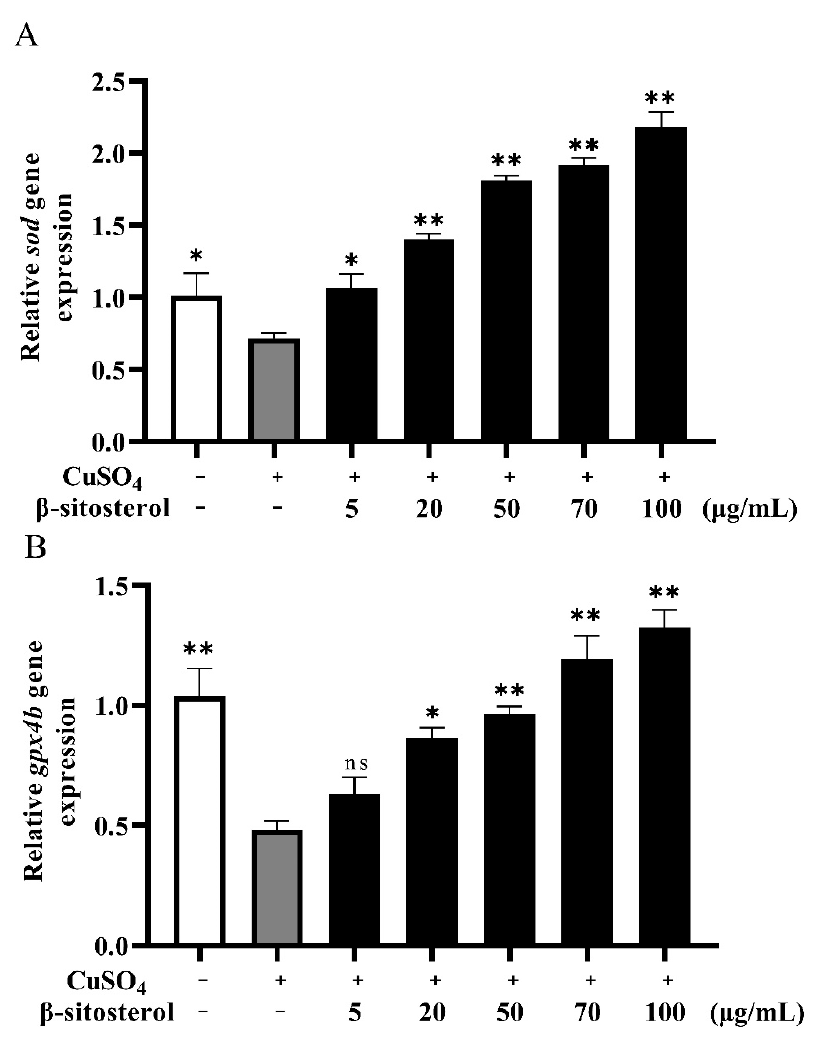
Figure 4. Relative expressions of antioxidant-related genes in zebrafish larvae treated with CuSO 4 and β -sitosterol for 24 h: ( A ) relative expression of the sod gene; ( B ) relative expression of the gpx4b gene. These data are expressed as the mean ± standard error based on three biological replicates. ns, no statistical significance, * p < 0.05 and ** p < 0.01 compared with the group treated with CuSO 4 alone.